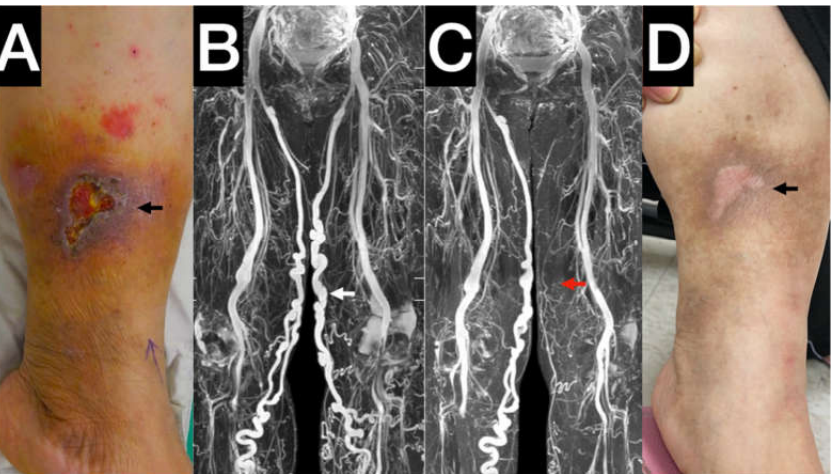
Figure 2. Typical stasis leg ulcer with venous reflux in the gaiter area (Also seen in Video S1). ( A ) Wet and nonhealing stasis leg ulcer. Black Arrow: unhealed venous ulcer with cellulitis. ( B ) Preintervention: The gated 3D-TSE-STIR MRA demonstrates the venous anatomy both leg veins. The white arrow indicates the diseased great saphenous vein of the wounded leg. ( C ) Postintervention: gated 3D-TSE-STIR MRA. The red arrow indicates the diseased great saphenous vein occluded. ( D ) Stasis leg ulcer healed after truncal ablation. Gated 3D-TSE-STIR MRA for venous systems. Black arrow :healed ulcers .